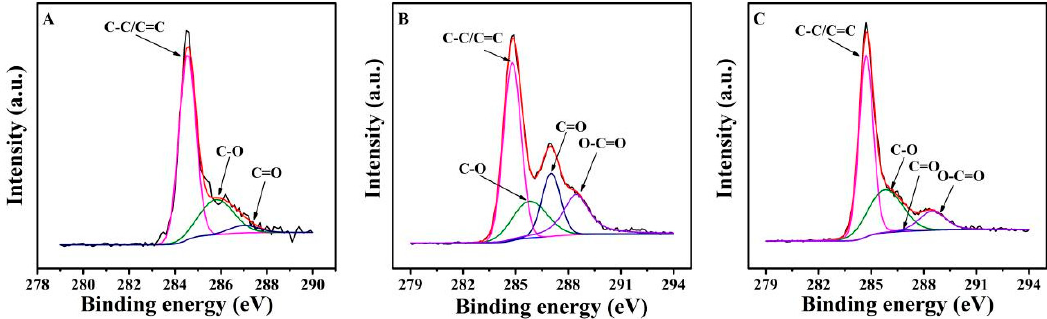
(cid:2876)(cid:2873)(cid:2906)(cid:2869) / (cid:2869) . (cid:2875)(cid:2873)(cid:2906) ( C ). (cid:2870) / (cid:2879)(cid:2868) .